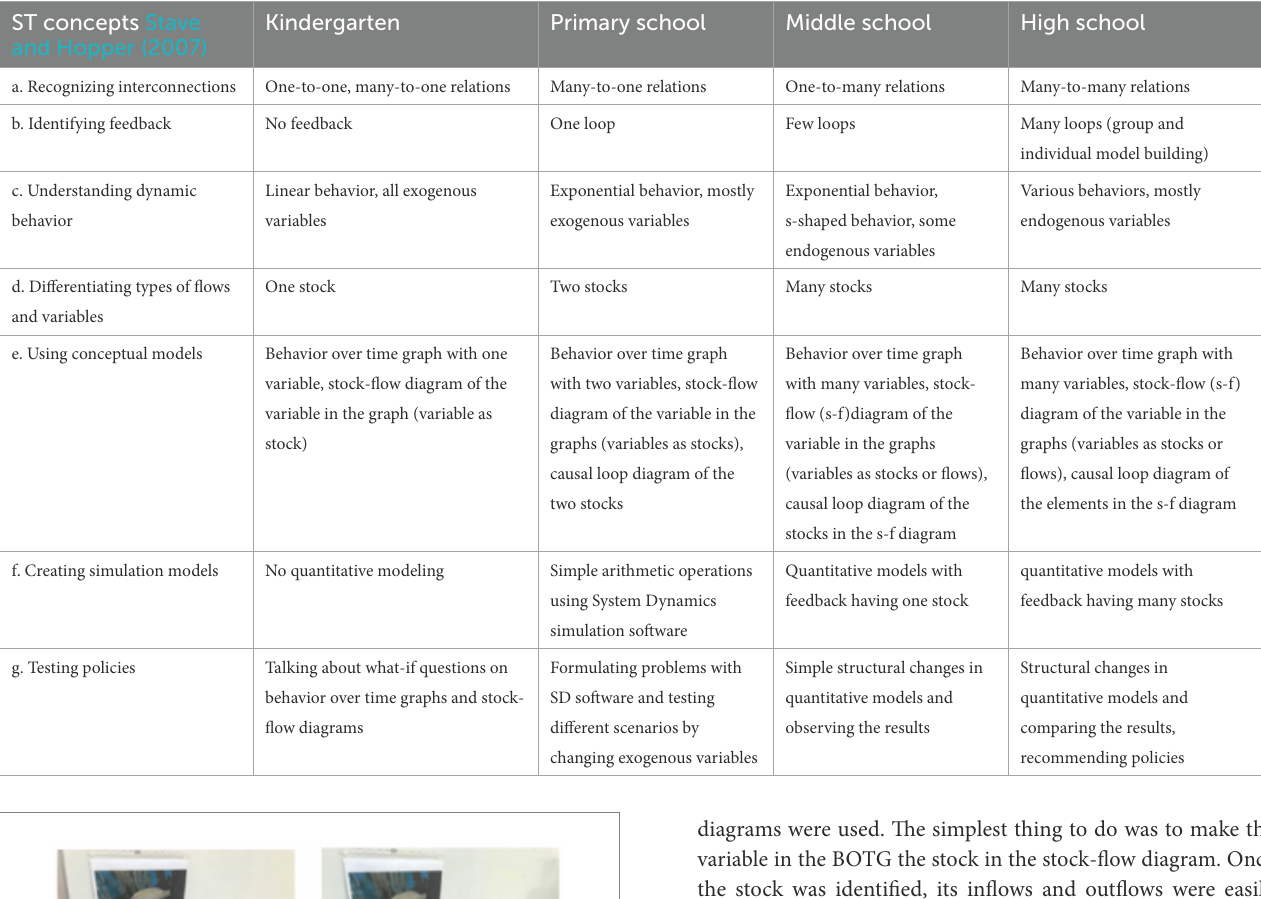
Table 1 Simple scope and sequence of ST/SD concepts for